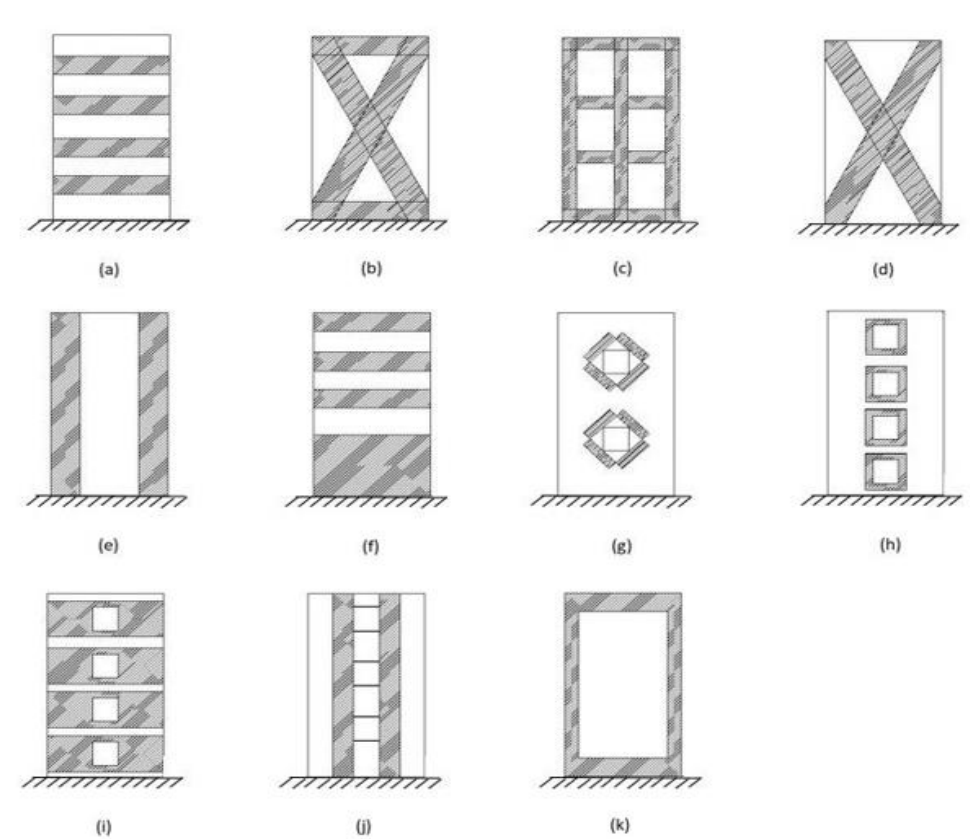
Figure 5. Typical schemes of strengthening shear walls with EB-FRP, where ( a – d ) modified from Sakr et al. [109]; ( e ) modified from Elnady [110]; ( f ) modified from Layssi et al. [111]; ( g – j ) modified from Aslani et al. [112]; ( k ) modified from Arabzadeh et al. [113].